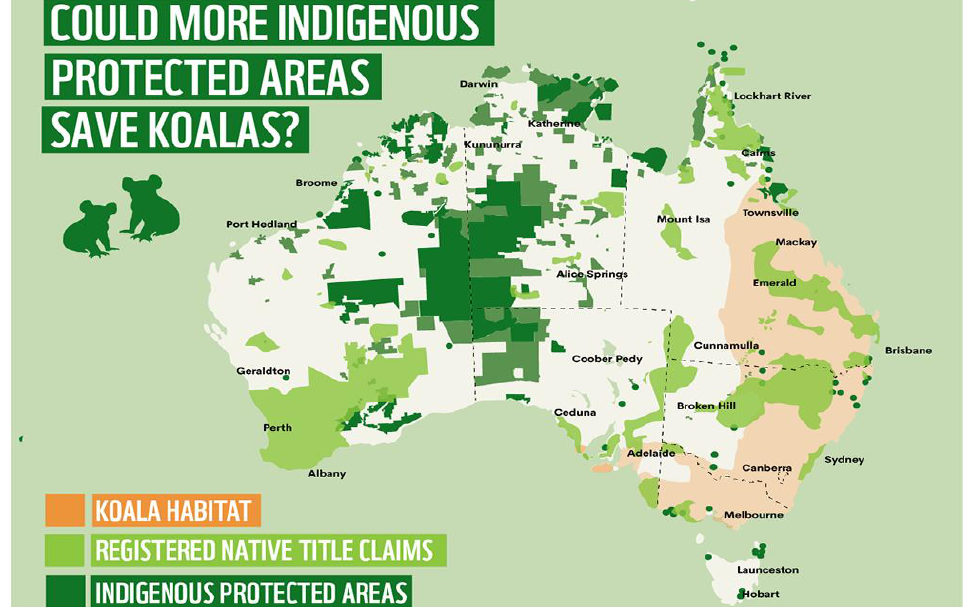
Figure 1. Map of Australia showing the location of Indigenous Protected Areas, existing registered Native Title claims, and viable koala habitats. Aboriginal and Torres Strait Islander people have established and built land and sea management arrangements to care for country and culture upon the successful claim of Native Title. © 2022 WWF-Australia (Map data courtesy of National Native Title Tribunal, Commonwealth of Australia, Department of Agriculture, Water and the Environment, Commonwealth of Australia, Geoscience Australia, Collaborative Australian Protected Areas Database — CAPAD, Commonwealth of Australia and Australian Land Tenure).